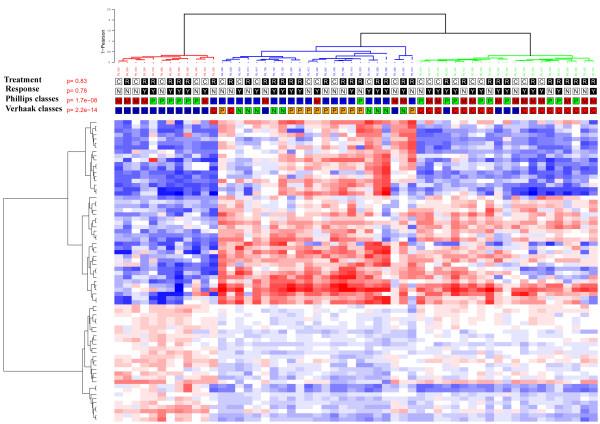
Unsupervised clustering of the 56 glioblastomas. Unsupervised hierarchical clustering of the 56 GBMs. The heatmap was done with the 72 probe sets used in the centroid classifier that was able to generate the 3 groups identified through unsupervised clustering (Additional file 1 Table S2). Samples and genes were clustered using Ward's linkage and 1-Pearson correlation coefficient. For each probe set, the lowest and highest intensity values are displayed in blue and red, respectively. Treatment: C = First-line chemotherapy, R = Radiotherapy. Response: N = non-responder, Y = responder. Phillips = class according to Phillips et al.'s classification [8], blue P = Proneural, green P = Proliferative, M = Mesenchymal. Verhaak = class according to Verhaak et al.'s classification [10], N = Neural, C = Classical, M = Mesenchymal, P = Proneural. The GBMs were classified into three groups: one group enriched in EGFR-amplified patients (n = 19, blue cluster), one group characterized by a high level of expression of immune and extra-cellular matrix genes (n = 12, red cluster) and one group characterized by a higher of expression of neural genes (n = 25, green cluster). There was a significant overlap when using Phillips et al.'s classes (Fisher's exact test p-value = 1.7 × 10-8) and a larger overlap with Verhaak et al.'s classes (Fisher's exact test p-value = 2.2 × 10-14).